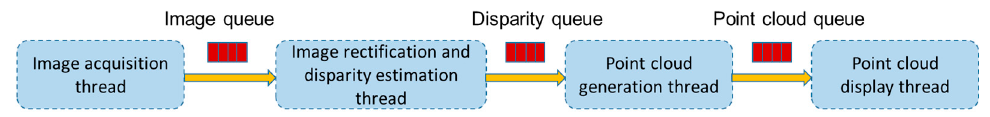
Figure 6. Flow diagram of images acquisition and 3-dimensional face generation.